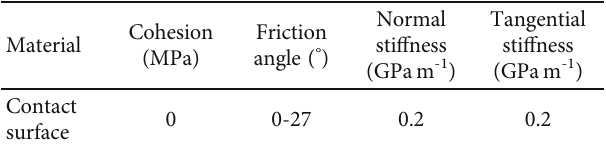
Table 2: Table of mechanical parameters of the contact surface. Material